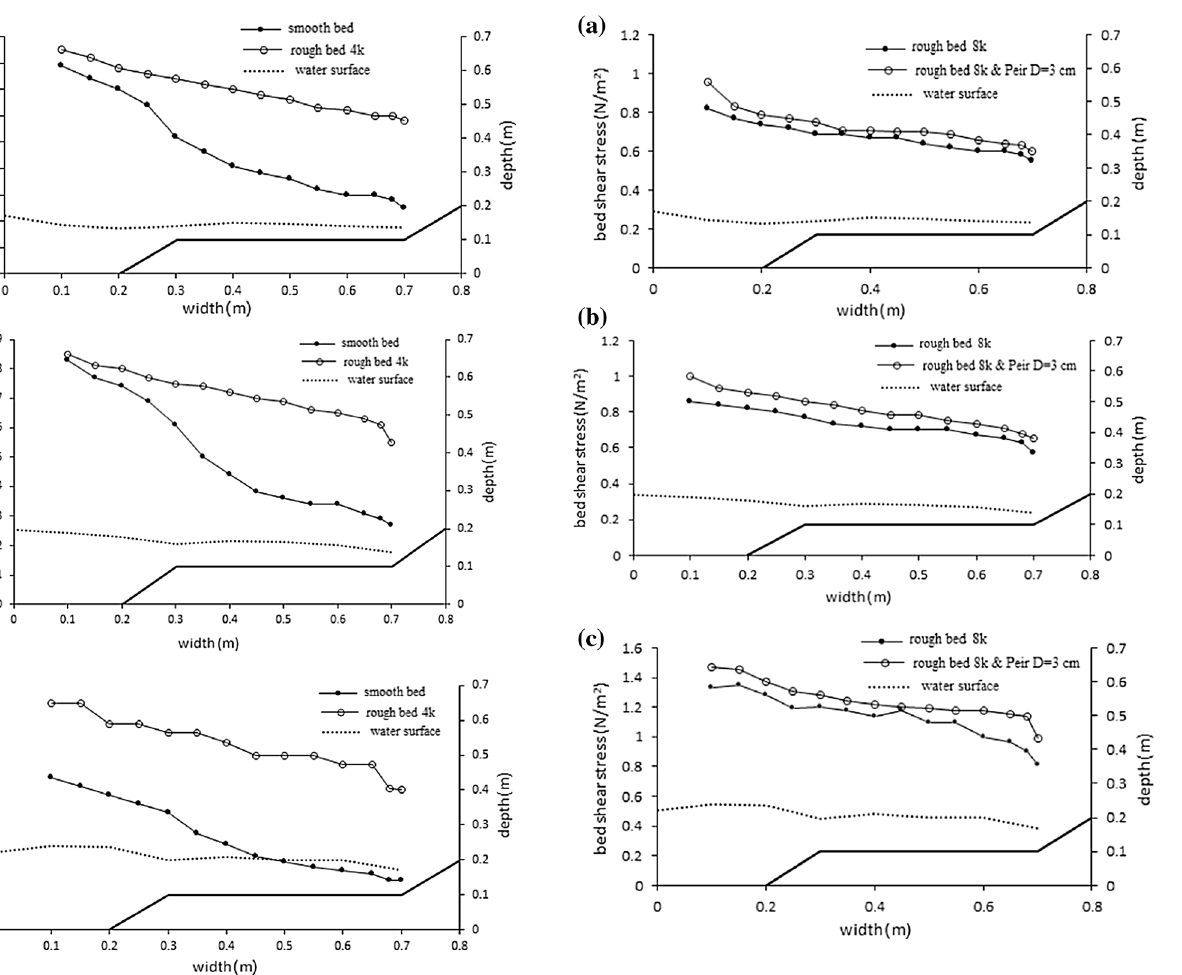
Fig. 6 Comparison of the bed shear stress in smooth and roughened compound channel (roughness distances of 4 k) a Q 1 , b Q 2 and c Q 3